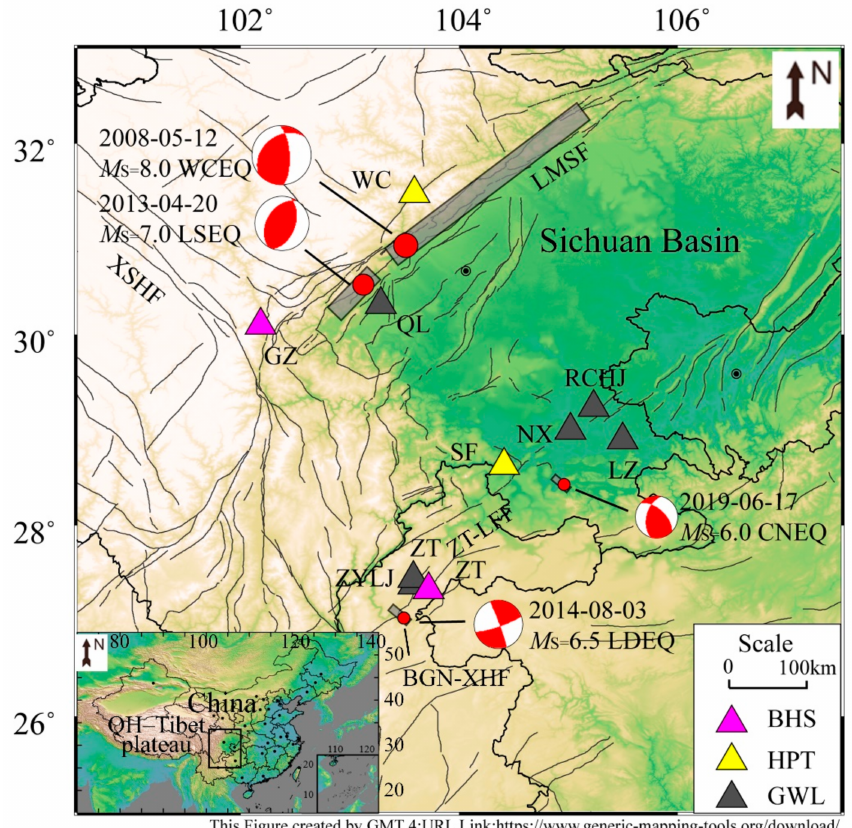
Figure 4. Location of the selected earthquakes and corresponding geophysical observations. Four focal mechanisms, from big to small, represent the Wenchuan (WCEQ), the Lushan (LSEQ), the Ludian (LDEQ), and the Changning (CNEQ) earthquakes. Triangles are locations of the observation stations. BHS: borehole strain, HPT: horizontal pendulum tiltmeter, and GWL: groundwater level.